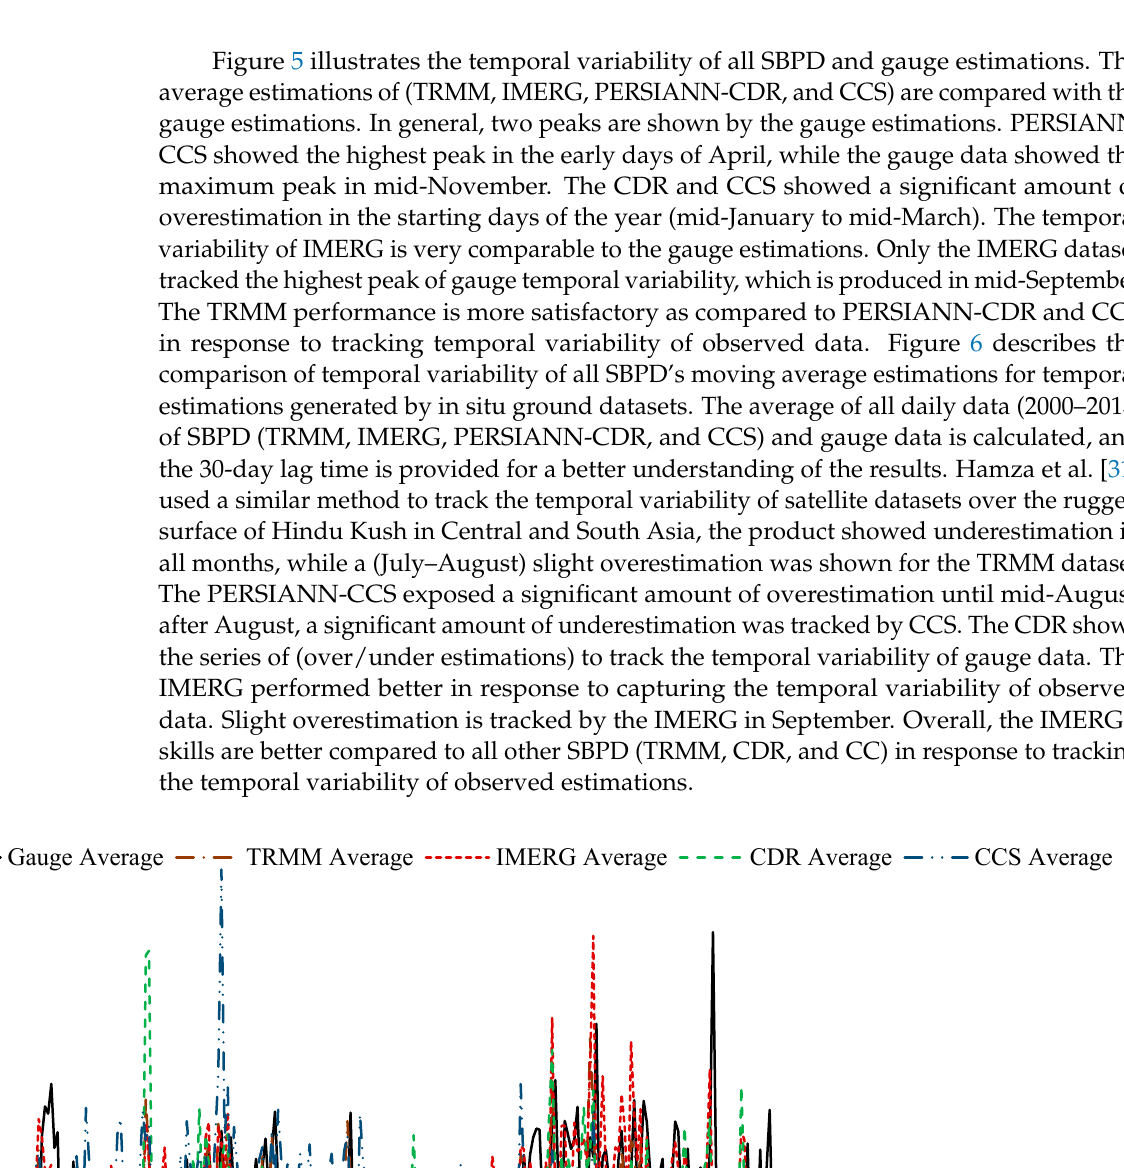
Figure 6. Comparison of moving averages of all SBPD and gauge estimations. 3.2. Ability of SBPD on a Daily Scale Figure 7 de fi nes the spatial variability of all datasets (TRMM, IMERG, PERSIANN- CDR, and CCS) and gauge observations over the mountainous domain of Tajikistan. Due to the mountainous region of the study area, a signi fi cant amount of precipitation is illus- trated by each dataset and gauging station. Northern Tajikistan and the Eastern Pamir highland region (75–300 mm of precipitation per year). Spots delineate the area with a rainy climate (more than 1200 mm per year) in the Gissar range’s southern windward slopes. The southern part of the country receives more rainfall in the winter season. Over low elevations, the maximum amount of precipitation is captured by all datasets and gauge observations. All SBPDs were unable to track precipitation over the northern high- lands of the study area. Results indicated that the CCS dataset revealed poor skill to cap- ture the daily spatial variability produced by gauge precipitation; a signi fi cant amount of underestimation is shown over the northern mountains. The performance of TRMM and CDR is reasonable over plain topography, but their performance is not satisfactory over hill topography, as indicated by the signi fi cant amount of overestimation. IMERG outper- formed all other selected datasets to capture spatial variability over the rugged surface of the study area.